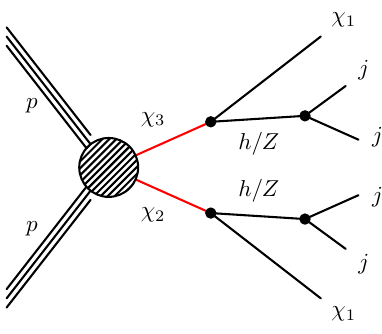
Figure 8 . Schematic representation of one of the processes leading to displaced Z or h bosons plus missing energy at the LHC. The red lines denote long-lived particles. Similar (cid:12)nal states arise from (cid:31) or (cid:31) pair production. Note that we do not specify the production mechanism of the 2 3 pair of neutral heavy fermions since it could be produced directly through electroweak processes or through the decay of the charged